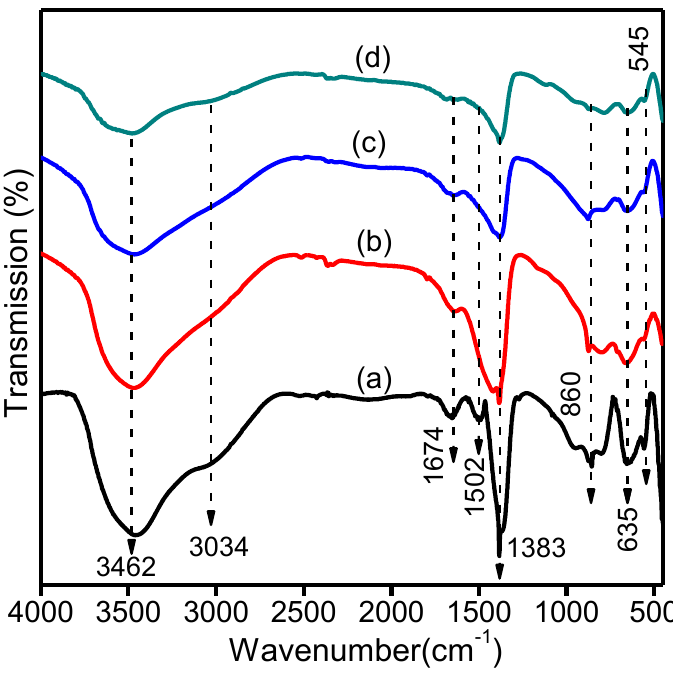
Figure 4. FT-IR spectrum of ( a ) Mg-Ca-Al-LDH, ( b ) Mg-Ca-Al-LDO, ( c ) after Cr adsorption and ( d ) after EBT adsorption of Mg-Ca-Al-LDO composites.